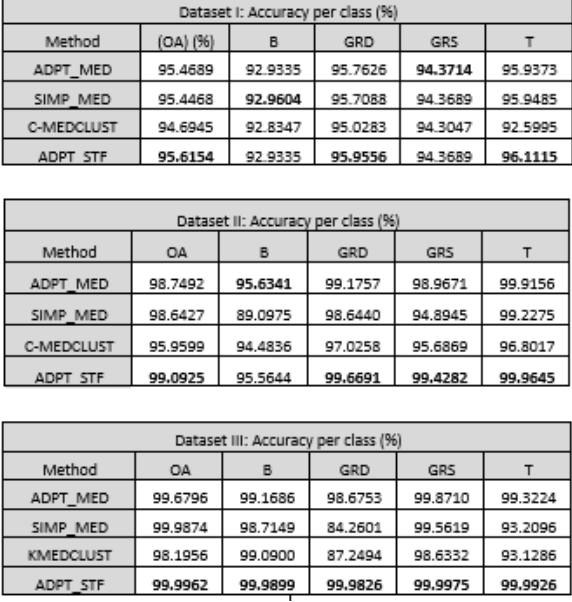
Table 4. Accuracy assessment for all datasets.